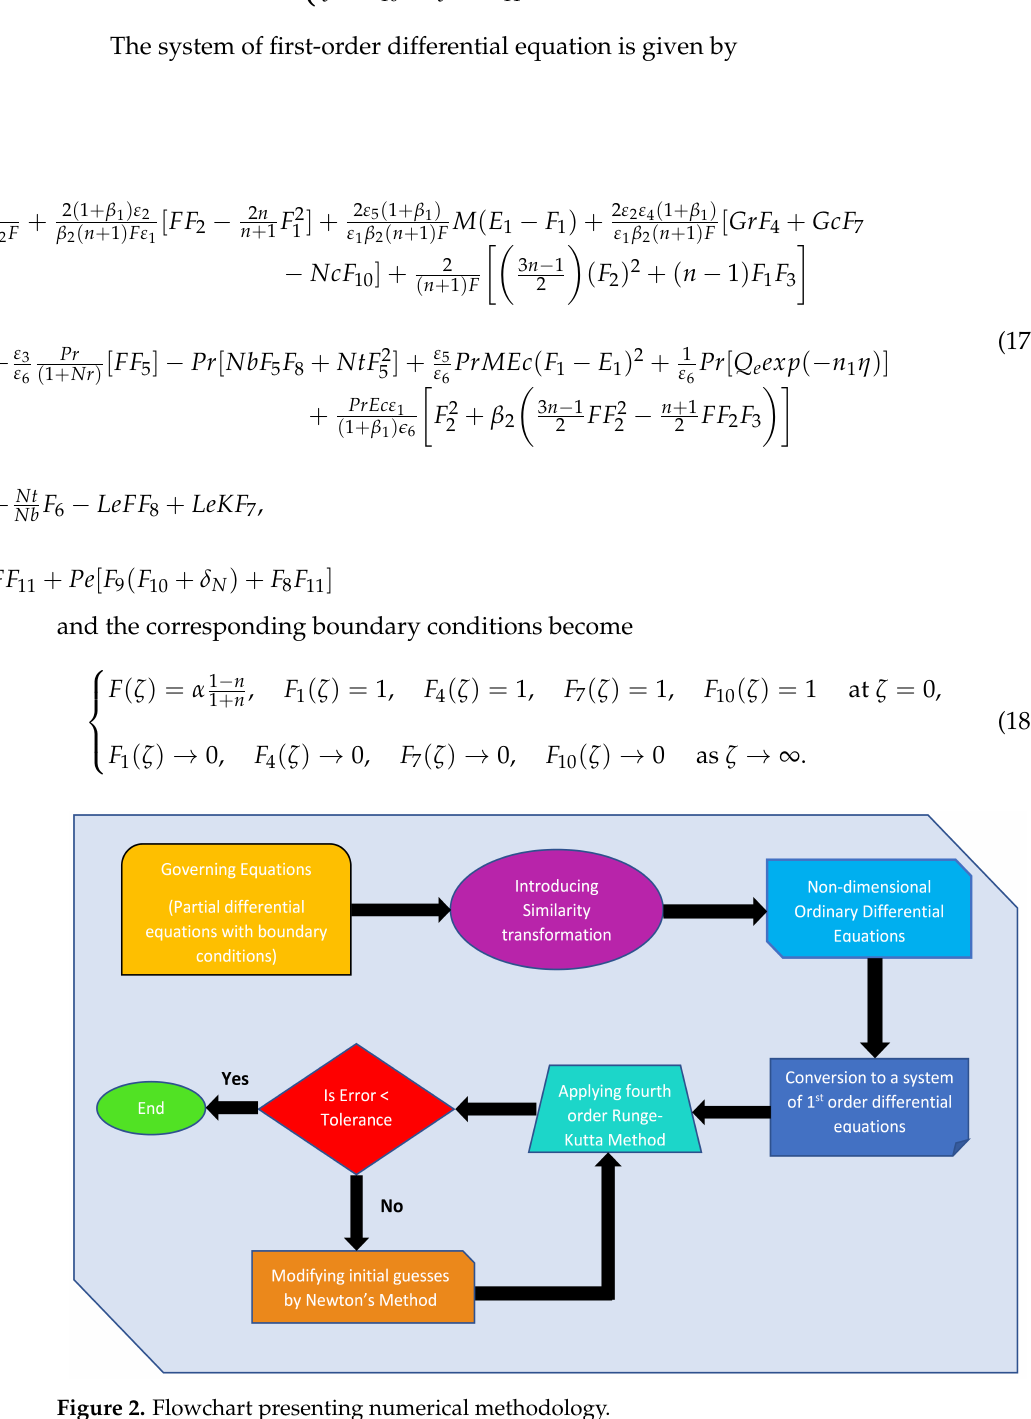
Figure 2. Flowchart presenting numerical